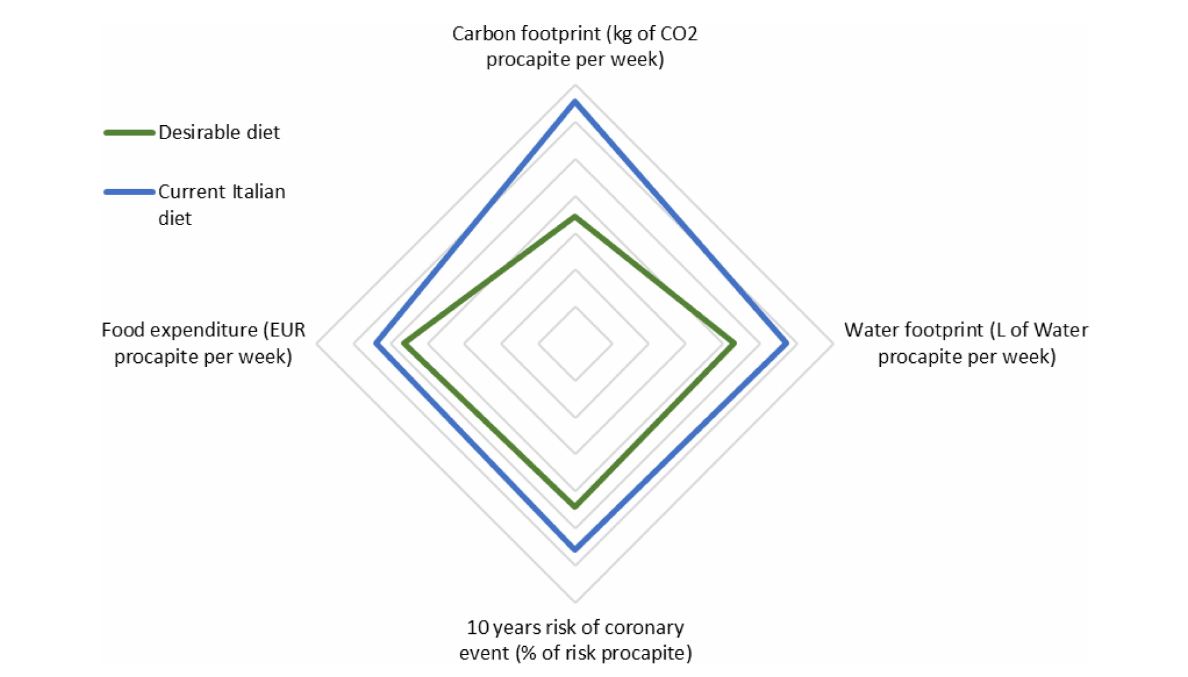
FIGURE7 Multi-criteria comparison of the desirable and the current Italian diet based on the results of the study (Source: Authors). Figure 7 has been obtained by calculating the variance for the desirable and the current Italian diet from the average of the results for each variable. The values for each variable highlighted in the results have therefore been divided by the average (between the desirable and the current diet) and multiplied by 100 to obtain the variance showed.